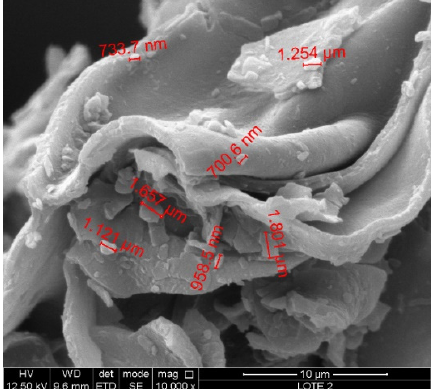
Figure 5. Micrographs SEM of the purified raw bentonite clay.